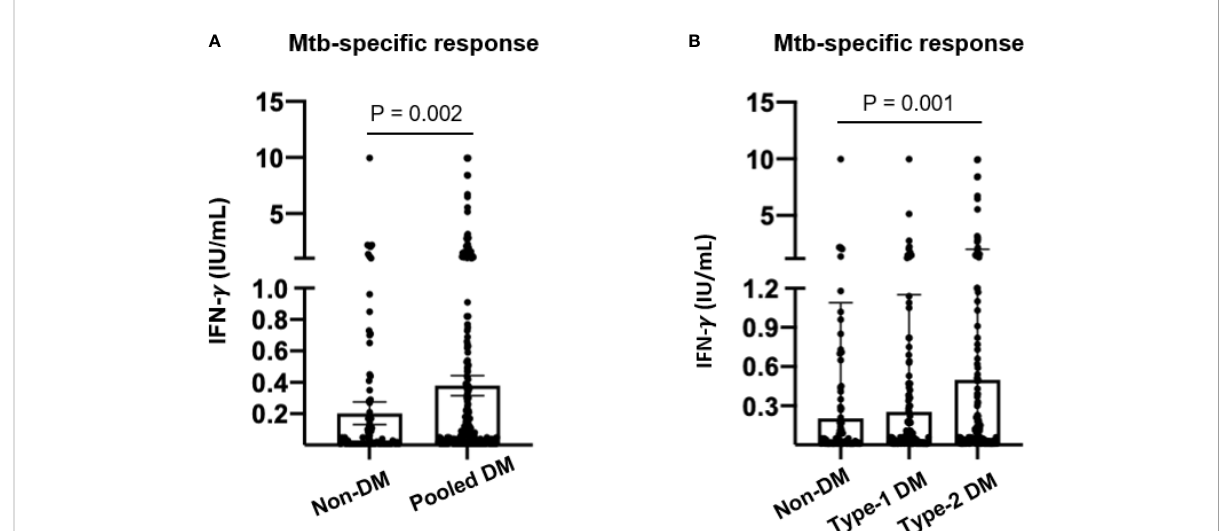
FIGURE 3 Interferon-gamma plasma levels in response to Mtb-speci fi c antigens by non-diabetic and diabetic patients. Whole blood from study population was stimulated or not with Mtb-speci fi c antigens (ESAT-6, CFP-10 and TB7.7) by using QuantiFERON-TB Gold in Tube (QFT-GIT) assay for 18- 24h at 37°C. A) IFN-g-Mtb-speci fi c levels were compared among study population: (A) non-DM and pooled MD (T1D and T2D patients) or (B) non-DM, T1D and T2D. IFN- g . Mtb-speci fi c levels were determined by subtraction between Mtb-speci fi c antigens minus control tube (Nil). Each dot represents an individual value. DM, Diabetes Mellitus; T1D, type-1 DM; T2D, type-2